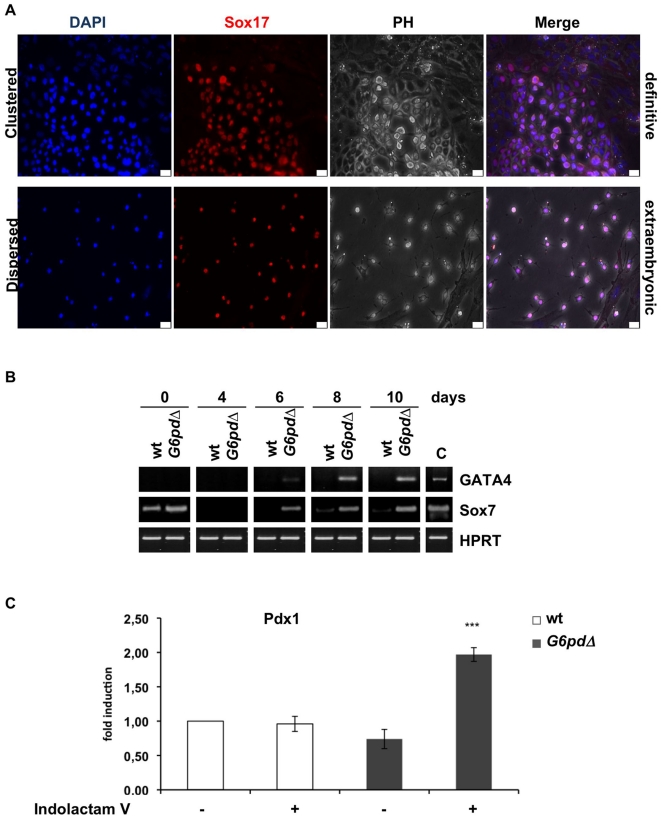
Definitive and extraembryonic endoderm differentiated from G6pdΔ ES cells.(A) Immunofluorescent staining of the differentiated mouse G6pdΔ ES cells for Sox17 (red) and nuclei (blue) at 8 days of neural differentiation. PH, phase contrast images. Scale bars, 25 µm. (B) RT-PCR analysis of the endodermal markers GATA4 and extraembyonic endodermal markers Sox7 during differentiation. Lane C, positive control, RNA isolated from embryos and yolk sacs at 9,5 dpc. Amplified HPRT is shown as a positive control. (C) qRT-PCR for Pdx1 in wt and G6pdΔ ES cells at 13 days after treatment with Indolactam V from day 8 during differentiation. Values are means ± SD (n = 2). *P<0.05; **P<0.01; ***P<0.001.